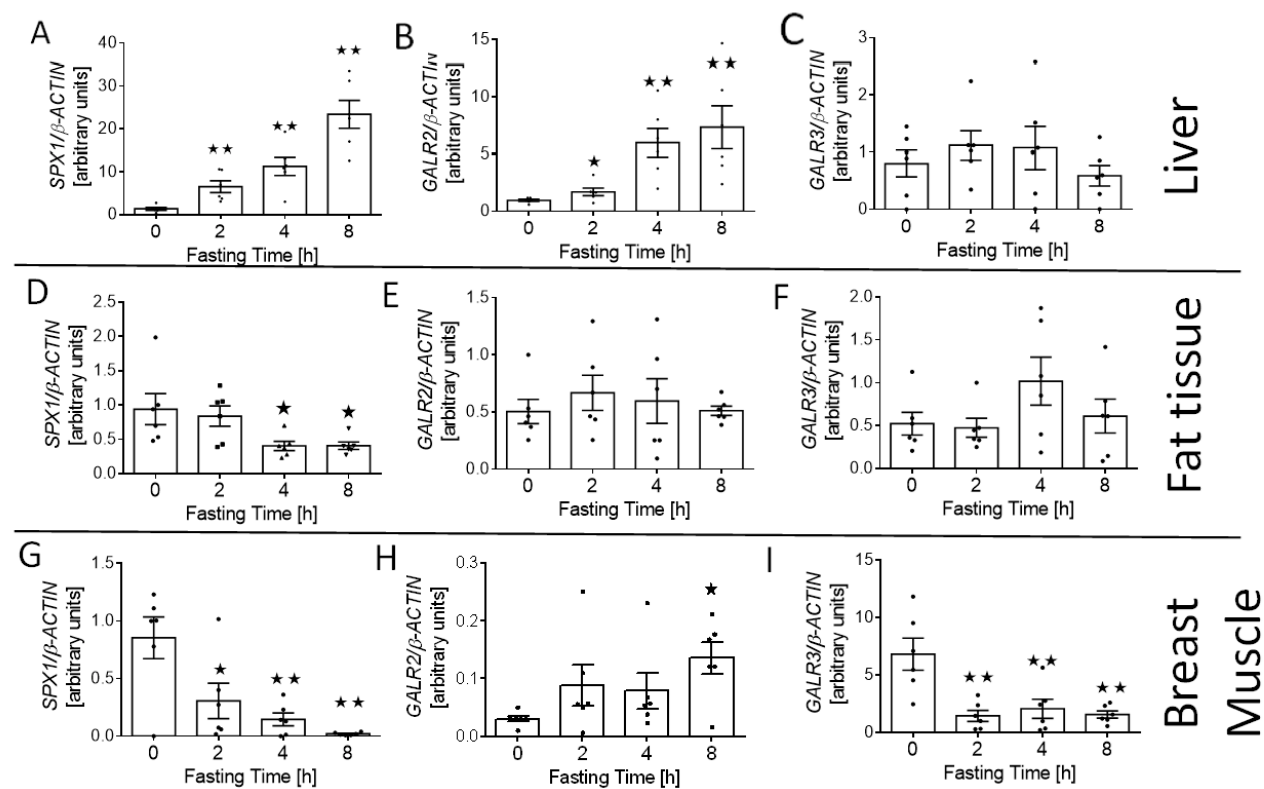
Figure 4. SPX1 , GALR2 , and GALR3 mRNA changes in liver ( A – C ), fat tissue ( D – F ), and muscle ( G – I ) in response to short-term food deprivation. Results are shown as the means ± SEM for each value ( n = 6). The dots represent the individual values obtained. Statistically significant changes are marked as asterisk symbol * p < 0.05 and ** p < 0.01 compared to time 0.